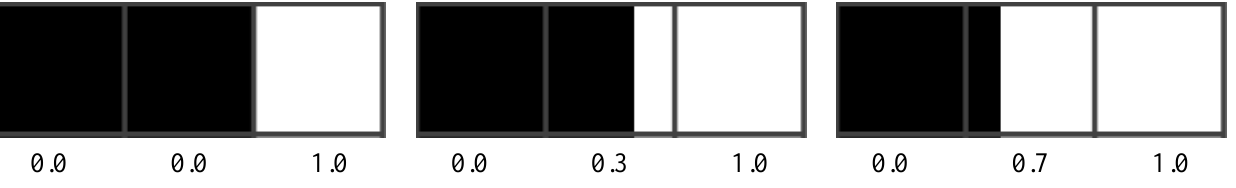
Figure 10. Pixel values (0 = black, 1 = white) originated on an horizontal line by different sampling grid positioning (gray line) respect to an abrupt black to white transition.